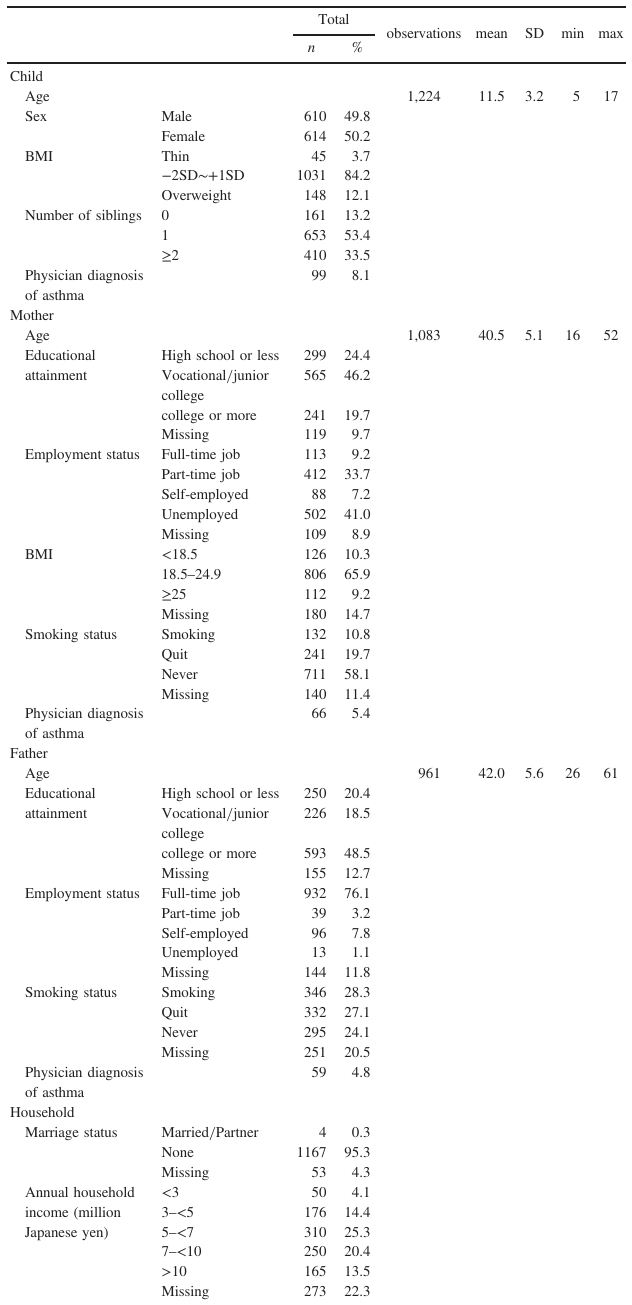
Table 1. Sociodemographic and asthma risk factor character- istics ( n =